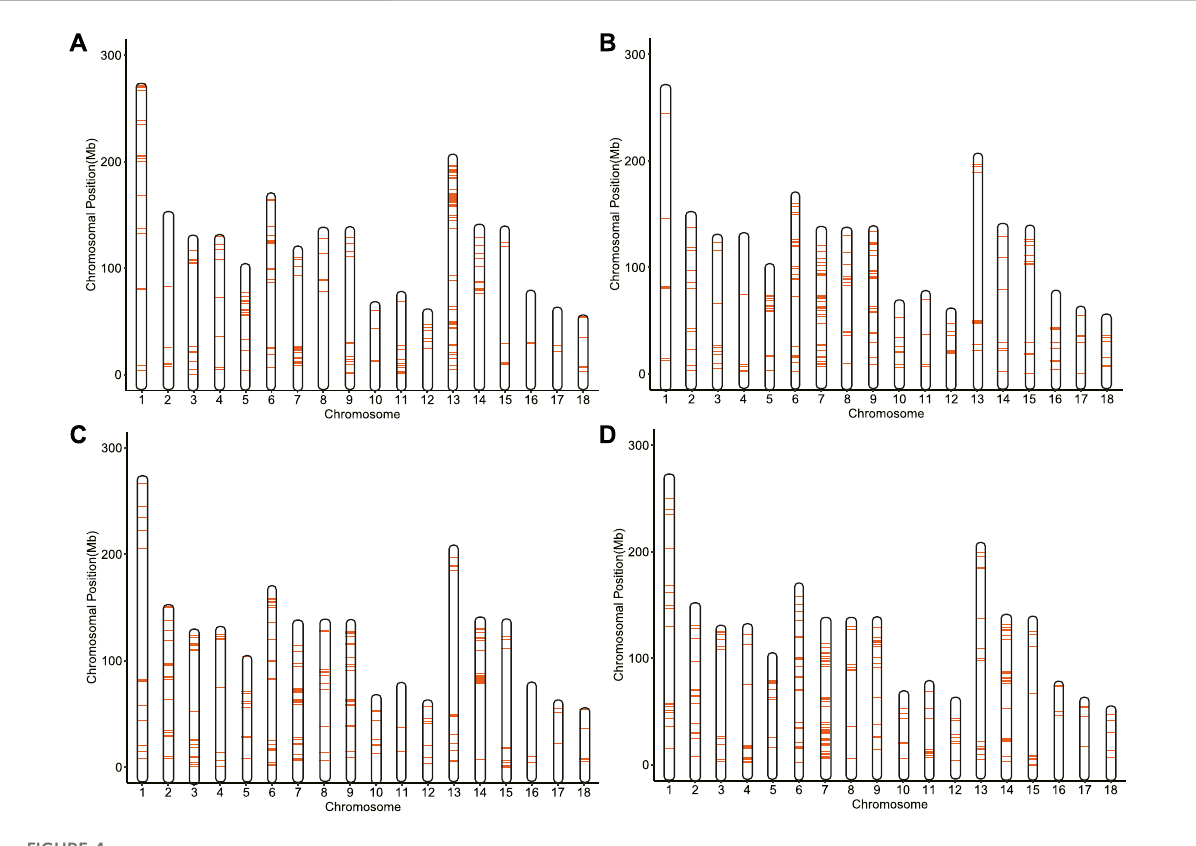
FIGURE 4 The maps of 320 selection signatures on pig chromosome. (A) Analysis between 114 and 115 days. (B) Analysis between 114 and 116 days. (C) Analysis between 114 and 117 days. (D) Analysis between 114 and 118